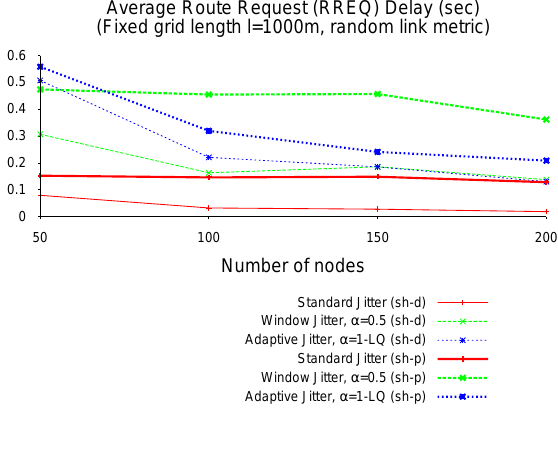
Figure 14. Route discovery delay, shortest-path and shortest-delay RREQ